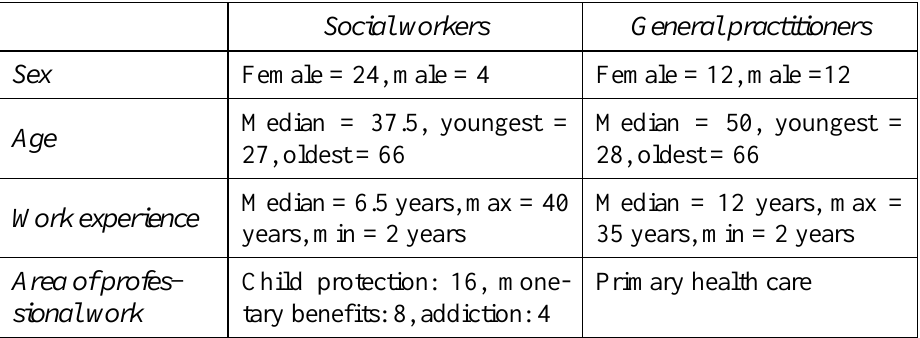
Sample overview Social workers General